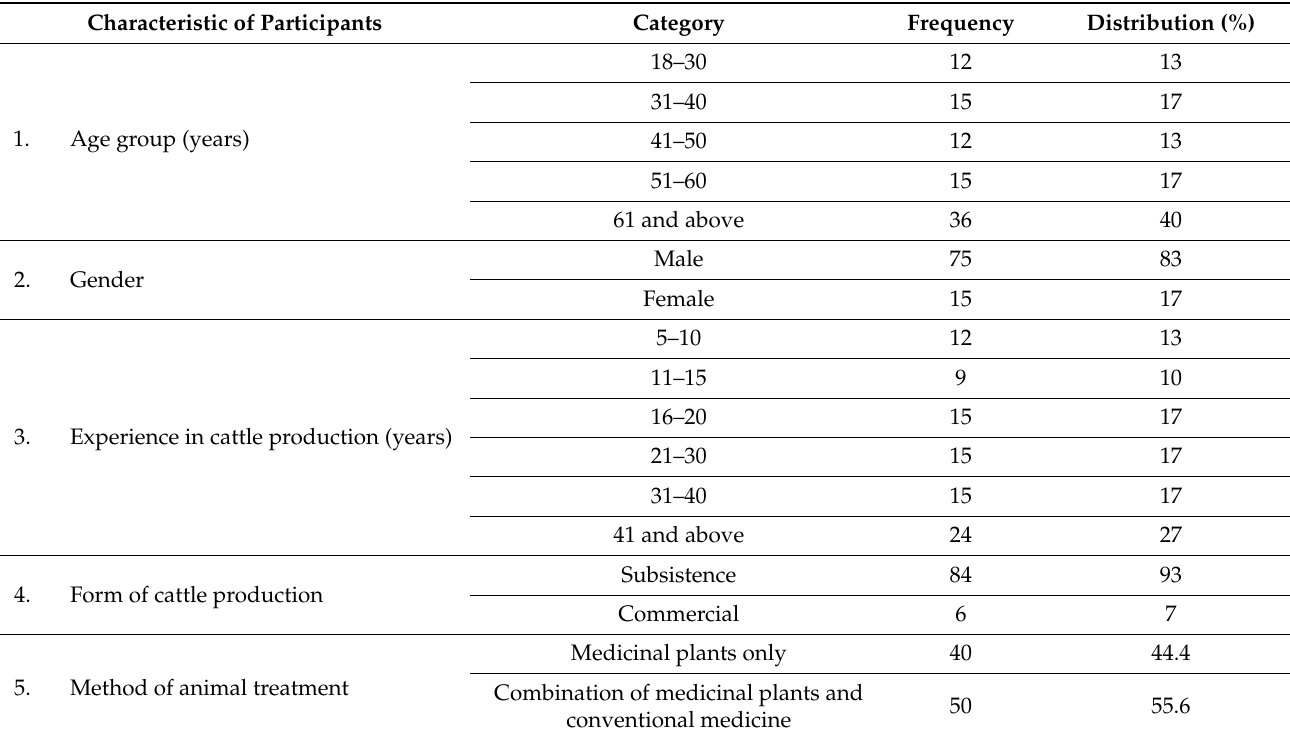
Table 1. Demographic information of participants engaged in the study ( n =